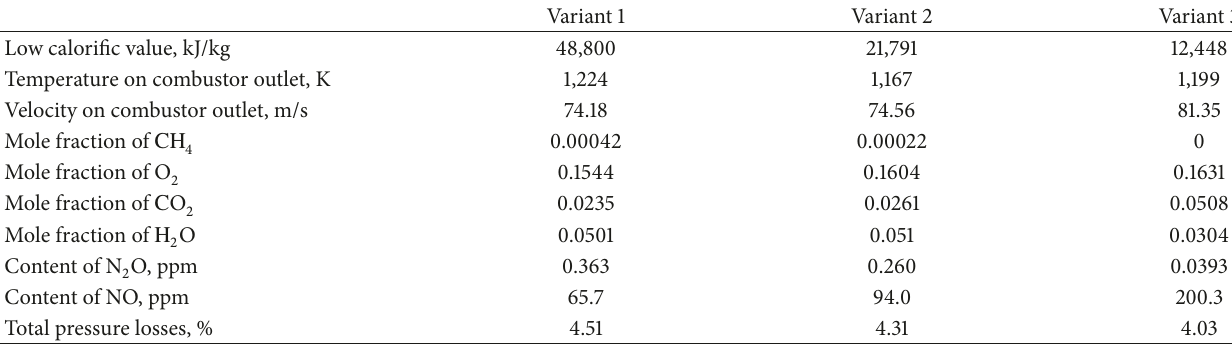
Table 4: Results of combustor